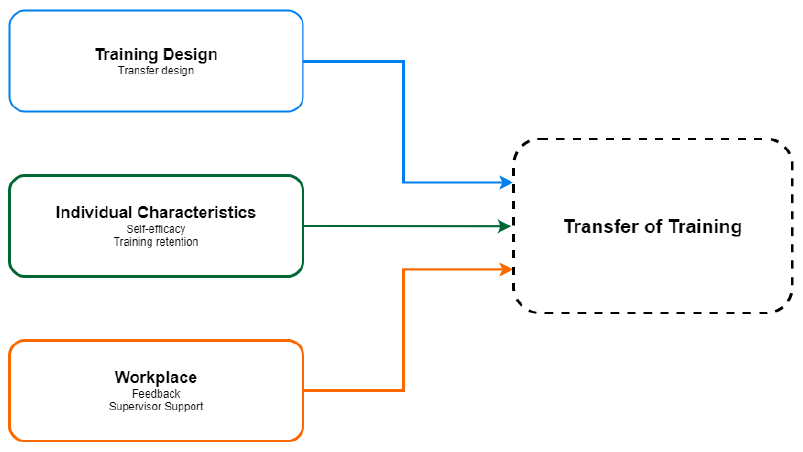
Figure 1. Transfer of